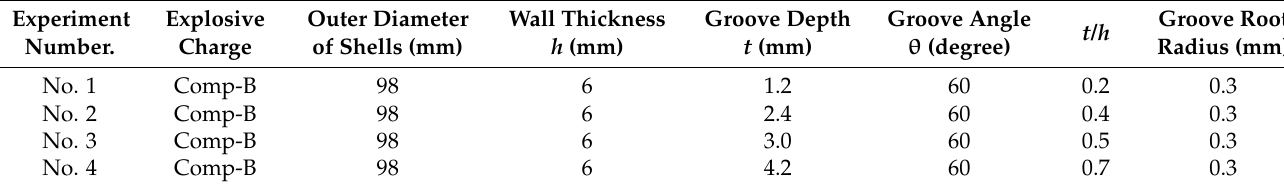
Table 2. Summary of experimental conditions.